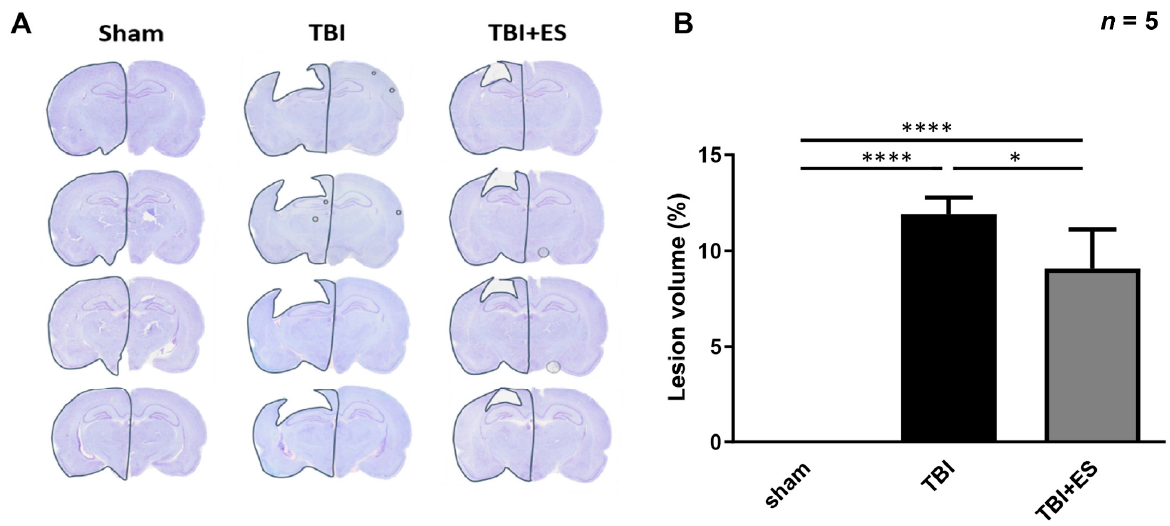
Figure 3. CES decreased the lesion volume of cortical contusion. ( A ) Representative pictures of cresyl violet staining. ( B ) Quantification of lesion volume. The data showed significantly decreased lesion volume in the TBI + ES group, suggesting neuroprotection by CES. Values are expressed as the mean ± SEM. **** p < 0.0001, * p < 0.05.